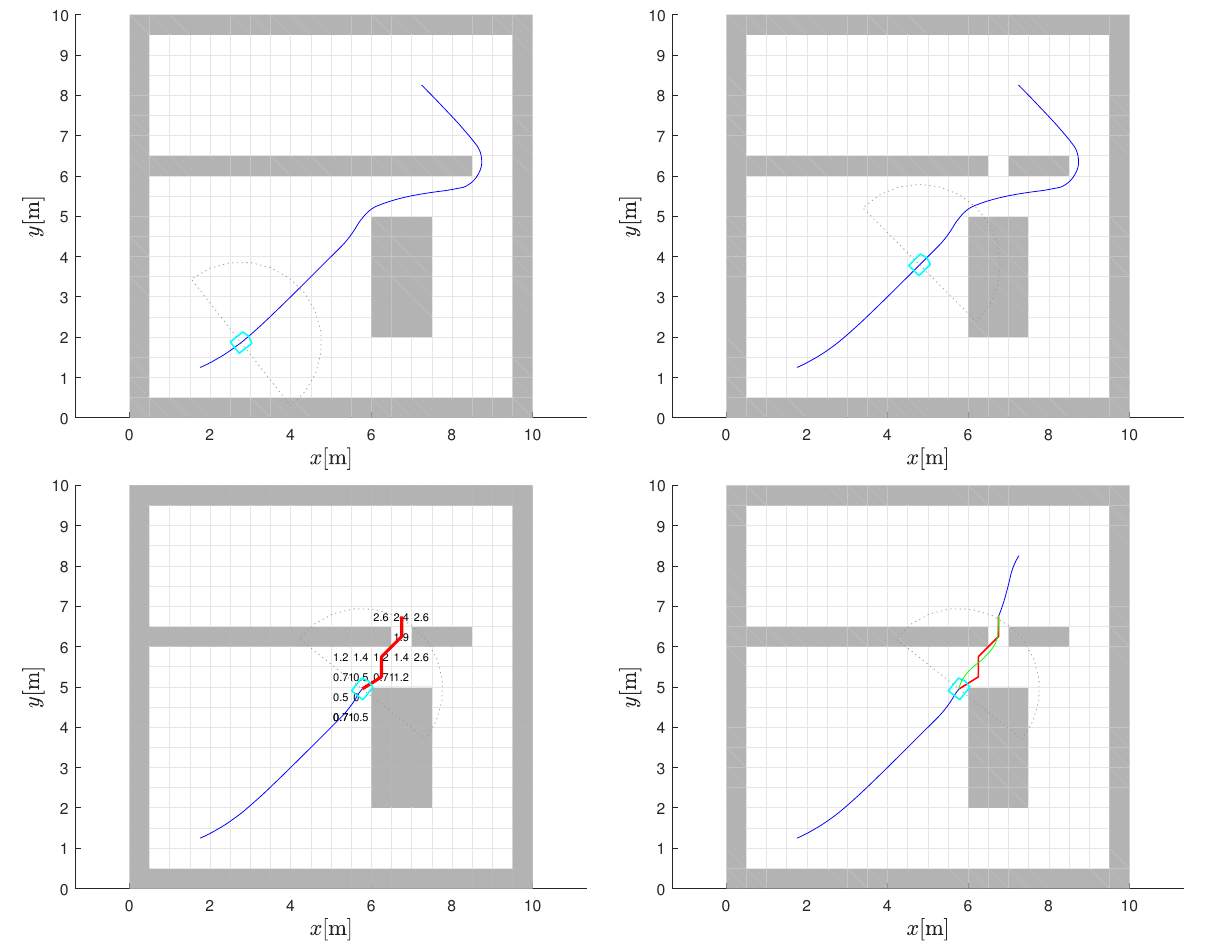
Figure 9. Path planning with obstacle clearance within sensor view. Initial path planned (blue line) based on knowledge of global static map is followed ( top-left and top-right ). Robot detects change in static map using sensor view (cleared cell) and computes A* bypass path (red line) to an unblocked cell beyond cleared cell ( bottom-left ). The smoothed bypass path (green line) connects to the gradient-descent path (blue line above the obstacle) based on CtG ( bottom-right